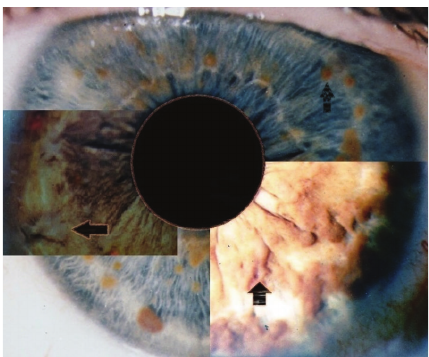
Figure 1: Morphological presentations of Lisch nodules. The upper and background image shows some shaped choroidal nodules. The image on the left shows nodules with ragged borders. The image on the right shows nodules with confluency (black arrows indicate Lisch